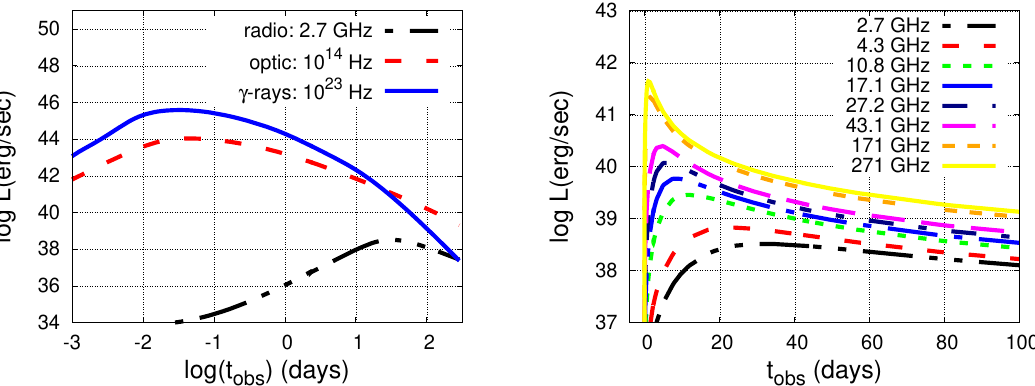
Figure 2. Multi-wavelength light curves (left panel) and radio light curves (right panel) of an indicative flaring episode produced by a single blob injected at z 0 = 10 − 3 pc with the the following properties: = 10 43 erg s − 1 , u exp = 0.4c, z = 1, γ max = 10 5 , p = 2, B 0 = 1 G, R 0 = 10 15 cm, L inj e final =1 pc, γ min 0 and δ = 10. The magnetic field and electron injection luminosity decrease linearly with radius.